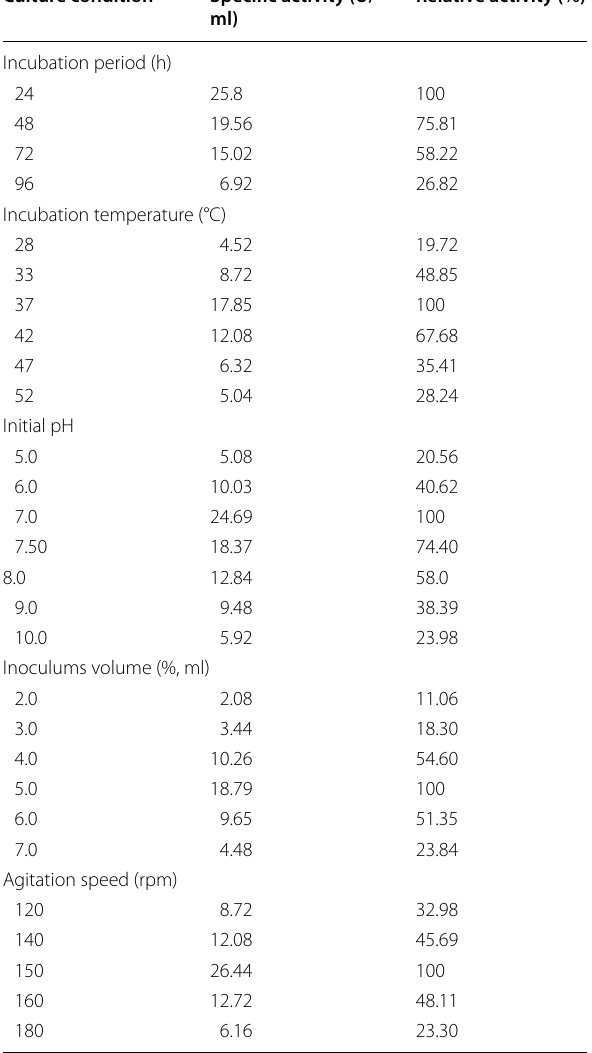
Table 2 Effect of culture conditions for production of extracellular Keratinase from Arthrobacter sp.